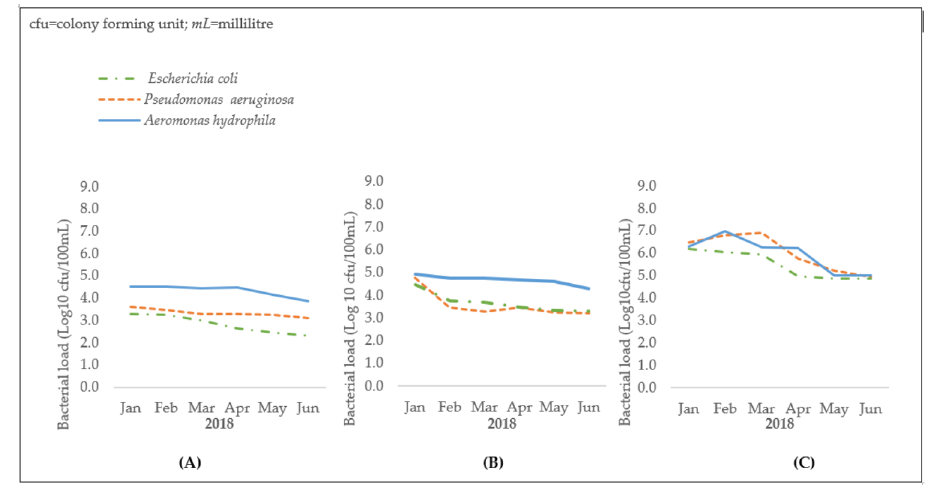
Figure 4. Bacterial loads in upstream ( A ) outfall ( B ) and downstream ( C ) water samples collected from the Onyasia stream, Accra, Ghana (January to June 2018).